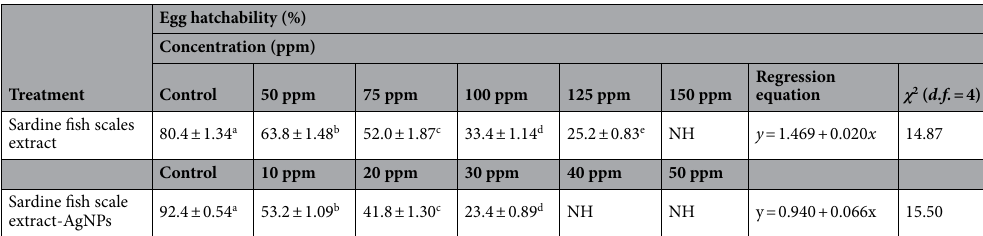
Table 3. Ovicidal activity of sardine fish scales extract against the malarial vector Anopheles stephensi . NH-No hatchability (100% mortality). Means followed by the same letter are not significantly different (P < 0.05).